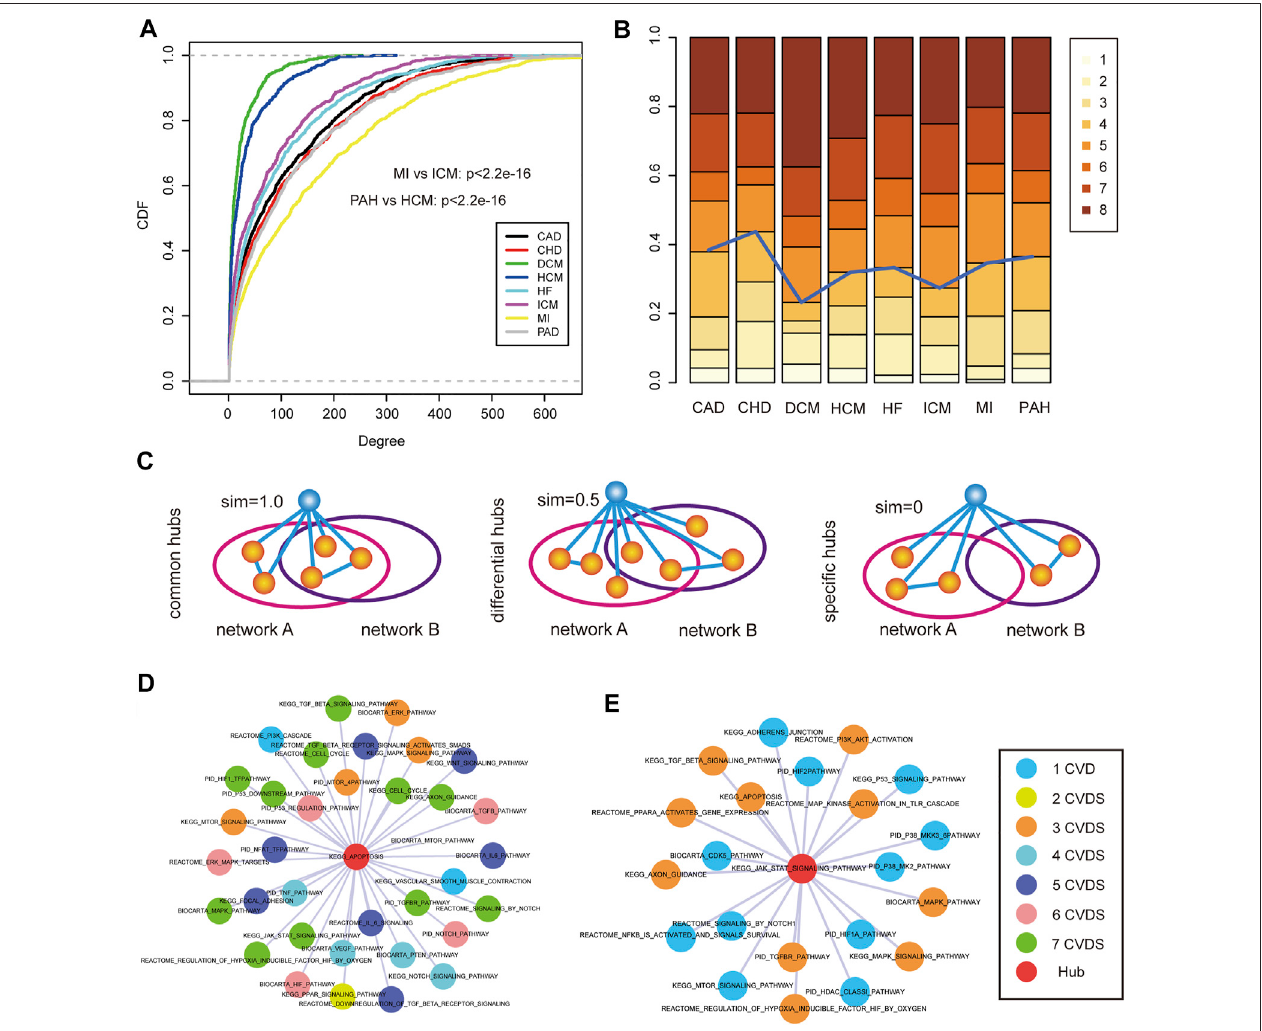
FIGURE5| Hub identi fi cation and analysisofdisease-related pathway crosstalk. (A) Cumulativedistributionfunctions ofthepathway degree ineach CVD. (B) The numberofhubswasdistributedin1 – 8CVDsinwhichthehubscouldoccur. (C) Hubpathwaysweregroupedintothreecategories:commonhubs,differentialhubs,and speci fi c hubs. (D) An example of common hub pathway of “ KEGG APOPTPSIS. ” Colors of nodes represents the number of CVDs. (E) An example of differential hub pathway of “ KEGG JAK STAT SIGNALING PATHWAY. ”